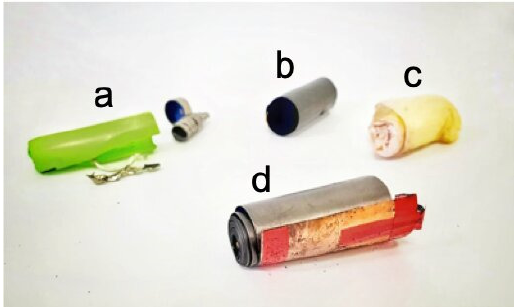
Figure 2. Cells components after disassembling: ( a ) case; ( b ) cathode; ( c ) separator; ( d ) anode.